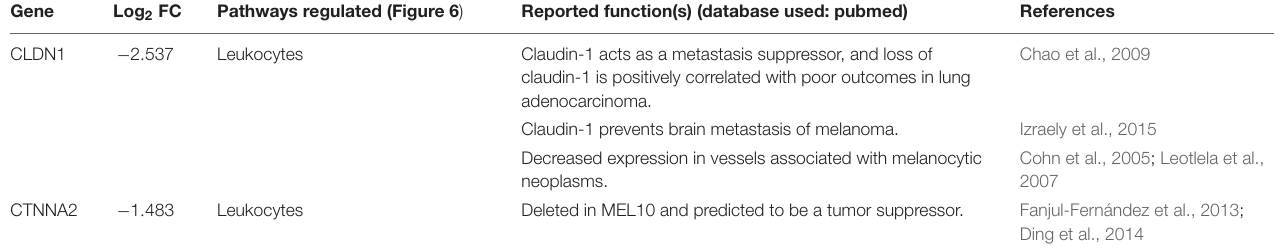
Frontiers in Neuroscience |